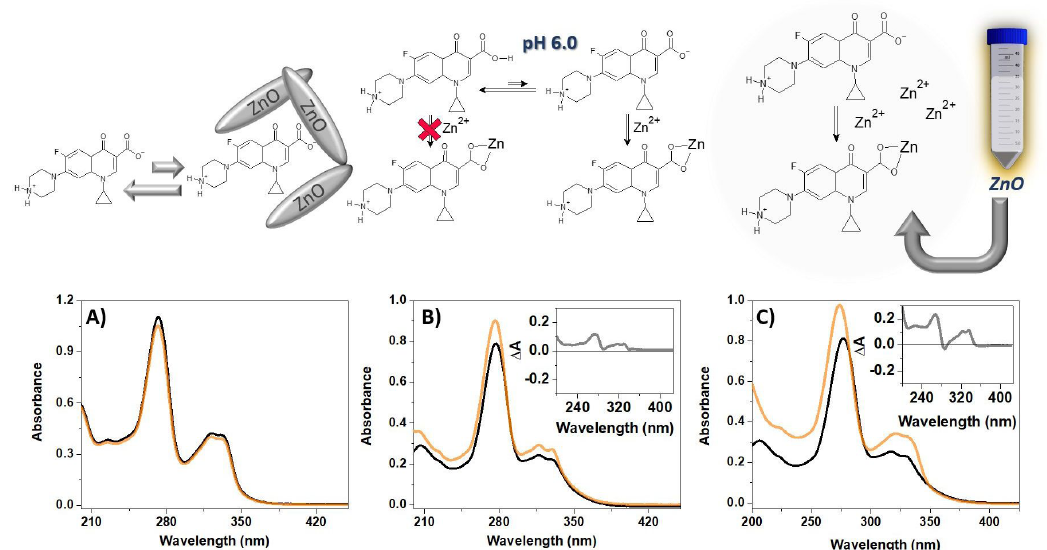
Figure 5. Binding of CIPRO on ZnO crystal surface and complexation with Zn 2+ . A) Spectra of CIPRO titrated with ZnO before (black) and after (yellow) centrifugation at 14,000 rpm. B) Spectra of CIPRO before (black) after addition of 0.20 mg/mL of ZnCl of CIPRO aqueous solution (black) and in the supernatant of a colloidal suspension of ZnO after two centrifugations at 14,000 rpm (yellow).